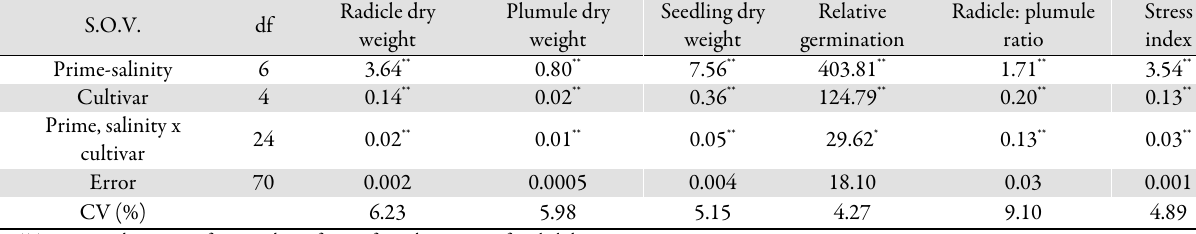
Table 3. ANOVA analysis showing the germination parameters of the studied traits S.O.V. df